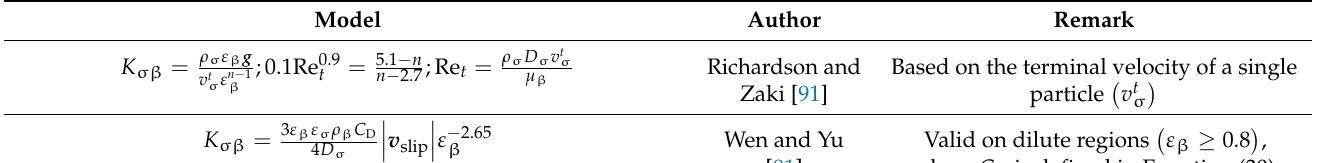
Table 3. Commonly reported drag force